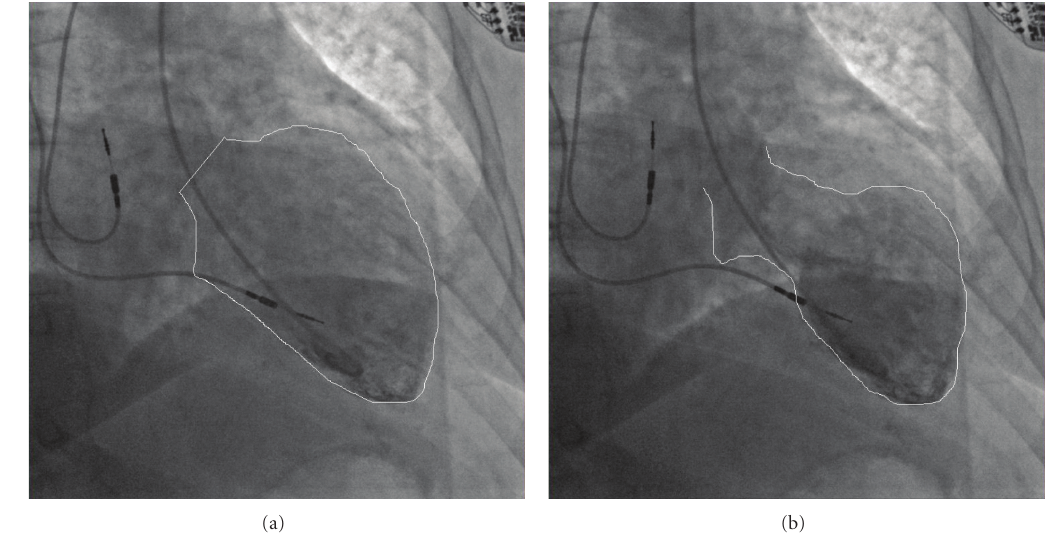
Figure 2: Ventriculography showing typical takotsubo-like shape of